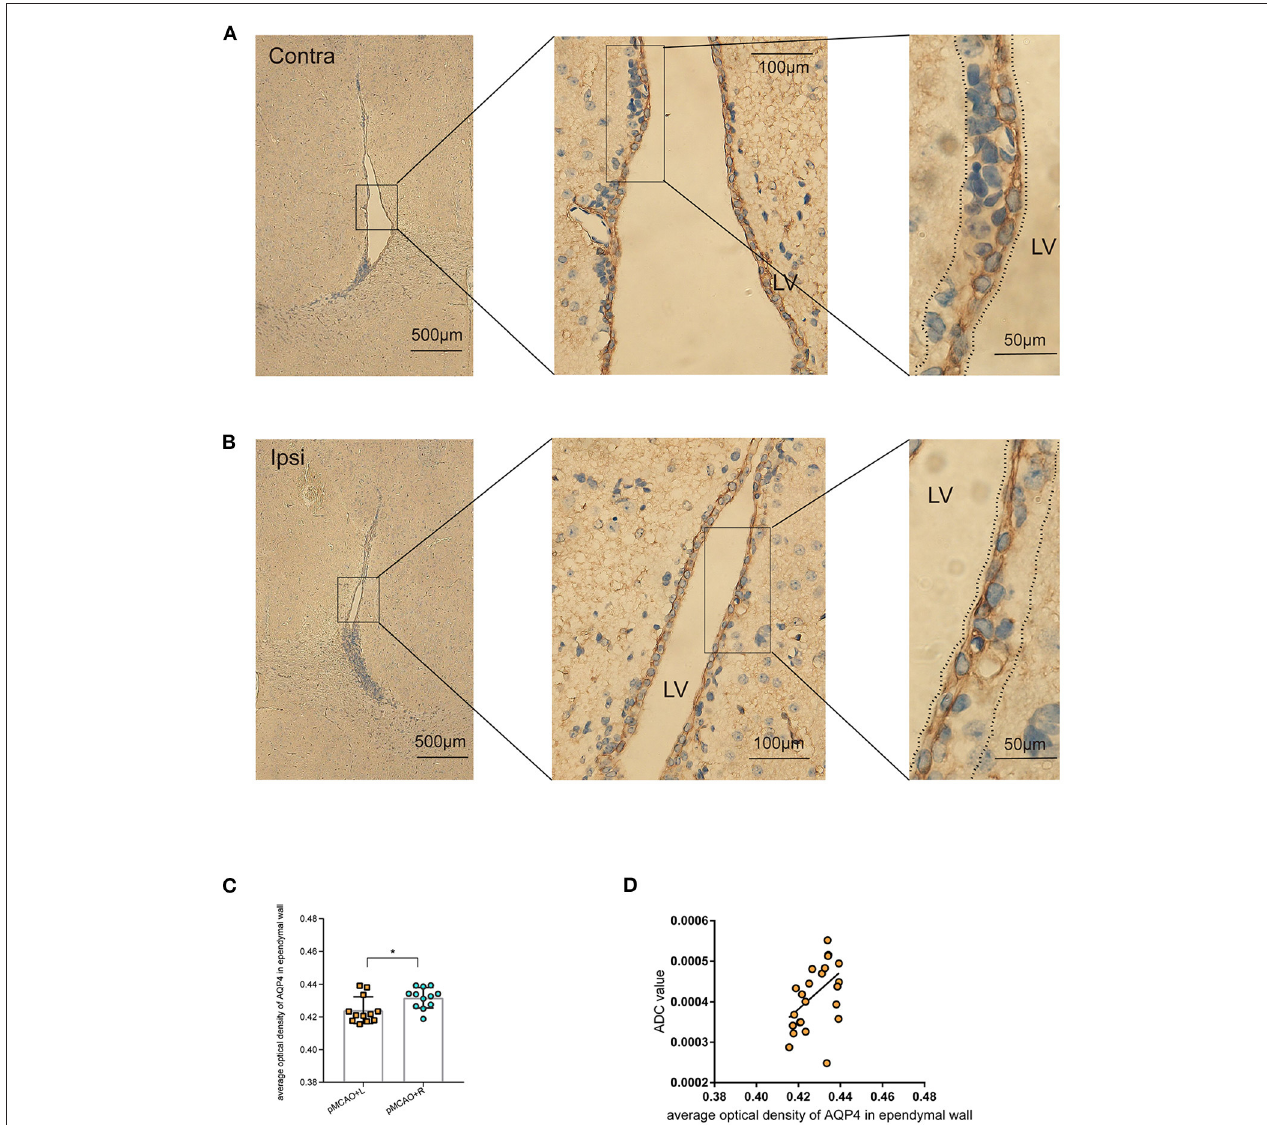
FIGURE 6 | Immunohistochemical staining of AQP4 in the LV ependymal wall of 150min post-pMCAO animals. (A,B) Representative images showing AQP4 immunohistochemical staining (brown) of coronal brain sections in the LV ependymal barrier of the bilateral brain in 150min post-pMCAO animals. These images revealed comparable morphology of the bilateral ependyma walls outlining LV. Boxed areas are enlarged successively from left to right. The areas between the dotted lines were used to quantify AQP4 expression in the LV ependymal wall. The scale bars are indicated in each box, and the magnification is 4 × , 40 × , and 100 × , respectively. (C) Quantification of at least 12 images (a minimum of three images per animal, n = 4) revealed changes in AQP4 expression. Compared with the contralateral pMCAO animals, AOD of AQP4 immunohistochemical staining was reduced in the LV ependymal wall of the ipsilateral pMCAO brain. (D) The corresponding ADC values in the periventricular zone of pMCAO animals at the 150min MR scan were positively correlated to the AOD of AQP4 in the immunohistochemical staining of bilateral LV ependymal walls. ROIs used for MRI quantification are as shown in Figure 2B